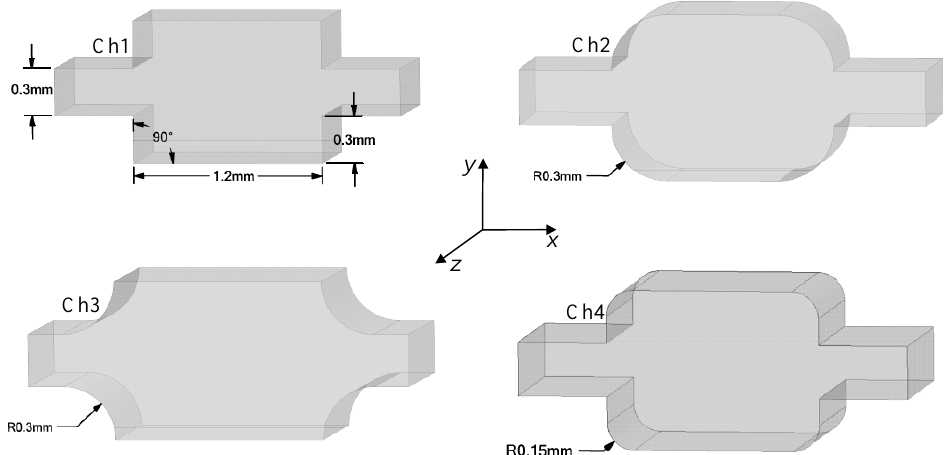
Figure 1. Investigated channels with given dimensions.